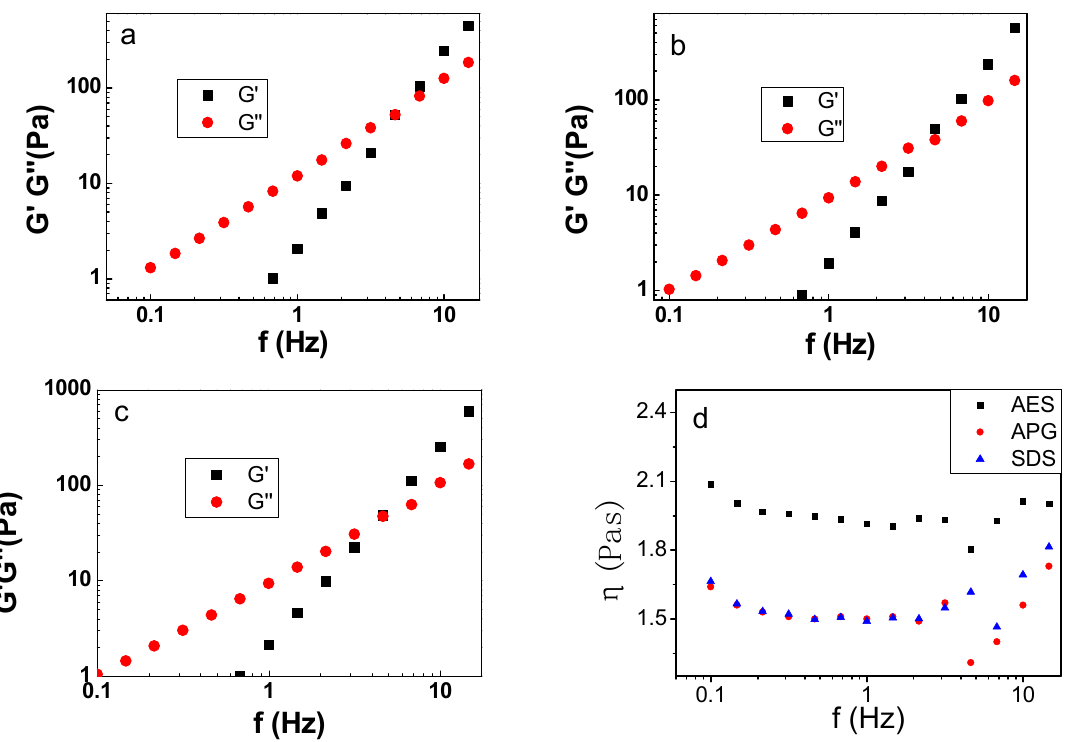
Figure 5. The viscoelasticity and viscosity as a function of shear rate of three emulsions a : AES, b : APG, c : SDS, d : the viscosity of three emulsions.